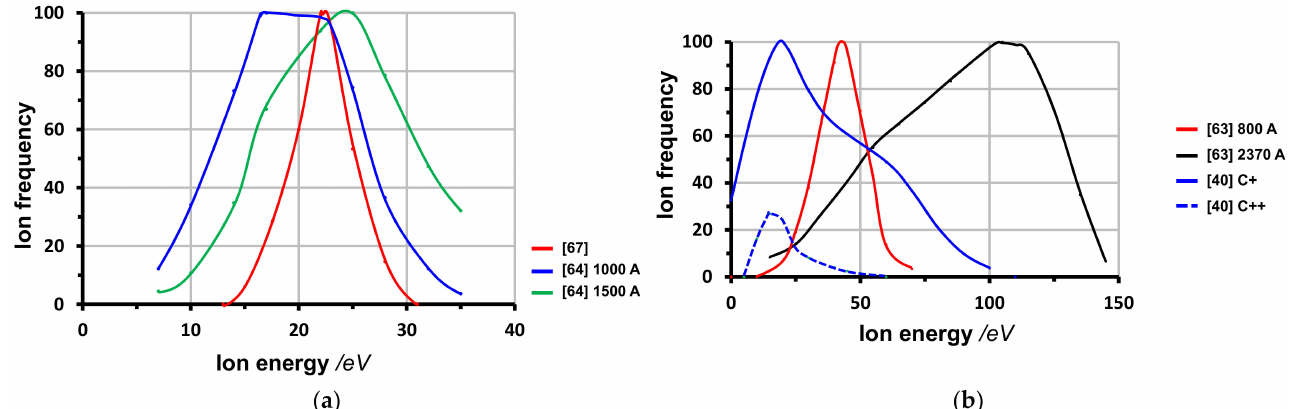
Figure 9. Energy distribution of the carbon ions, measured against ground ( a ) Filtered vacuum arc [67] and anodic Laser-Arc (pulse length 100 µ s, pulse maximum 1 kA/1.5 kA [64]). ( b ) Cathodic Laser-Arc (pulse length 100 µ s, pulse maximum 800 A/2370 A [63]) and filtered anodic Laser-Arc (pulse length 320 µ s, pulse maximum 1450 A